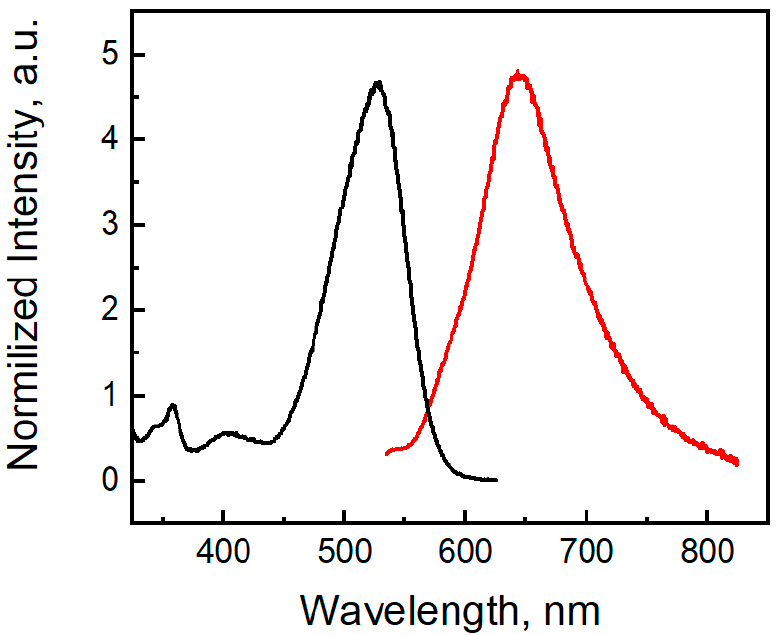
Figure 14. Excitation (black) and emission (red) spectra of compound 3 (4.75 µM) in